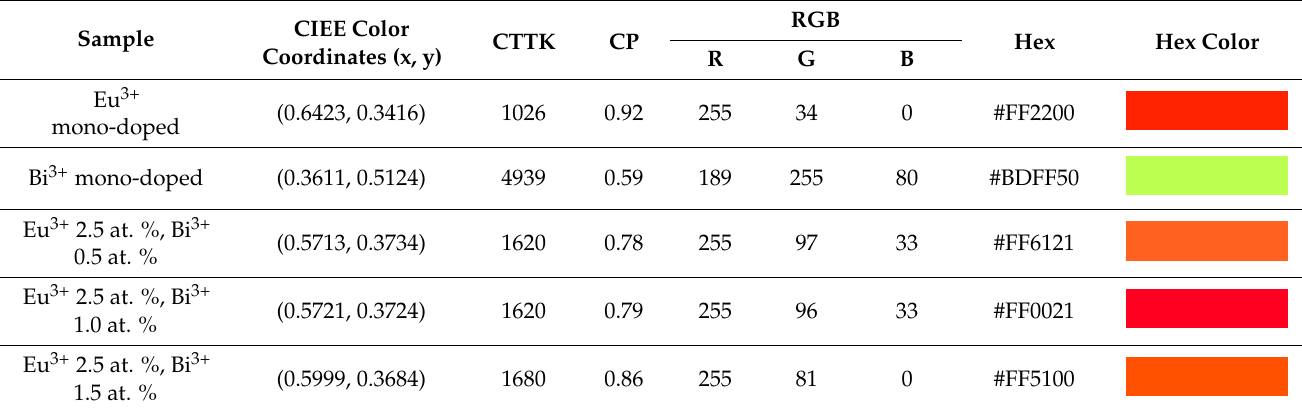
Table 2. Chromaticity coordinates (x, y), correlated color temperature (CCT), color purity (CP), RGB coordinates, and Hex color.